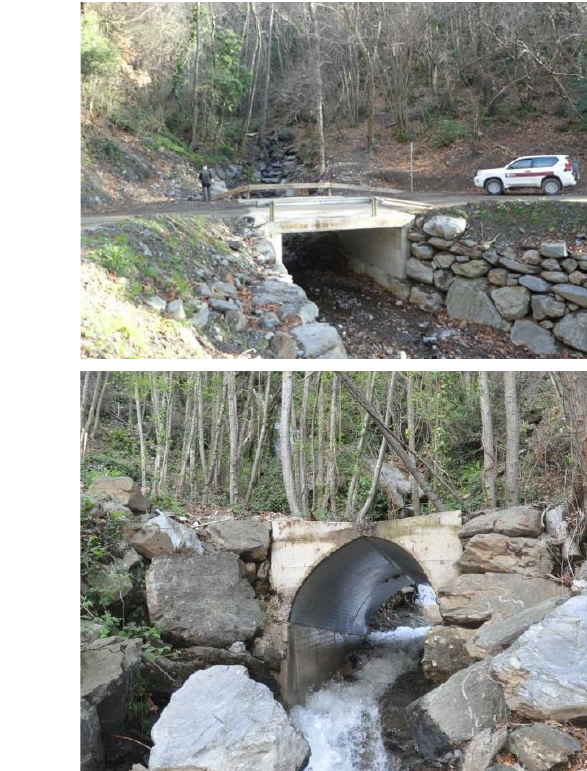
Figure 13. ( Left ) Artificial marshlands formed by shallow ponds with gravel and aquatic vegetation (70% Phragmites australis and 30% Iris pseudacorus ). ( Right ) Schematic draft from [ 40 ].